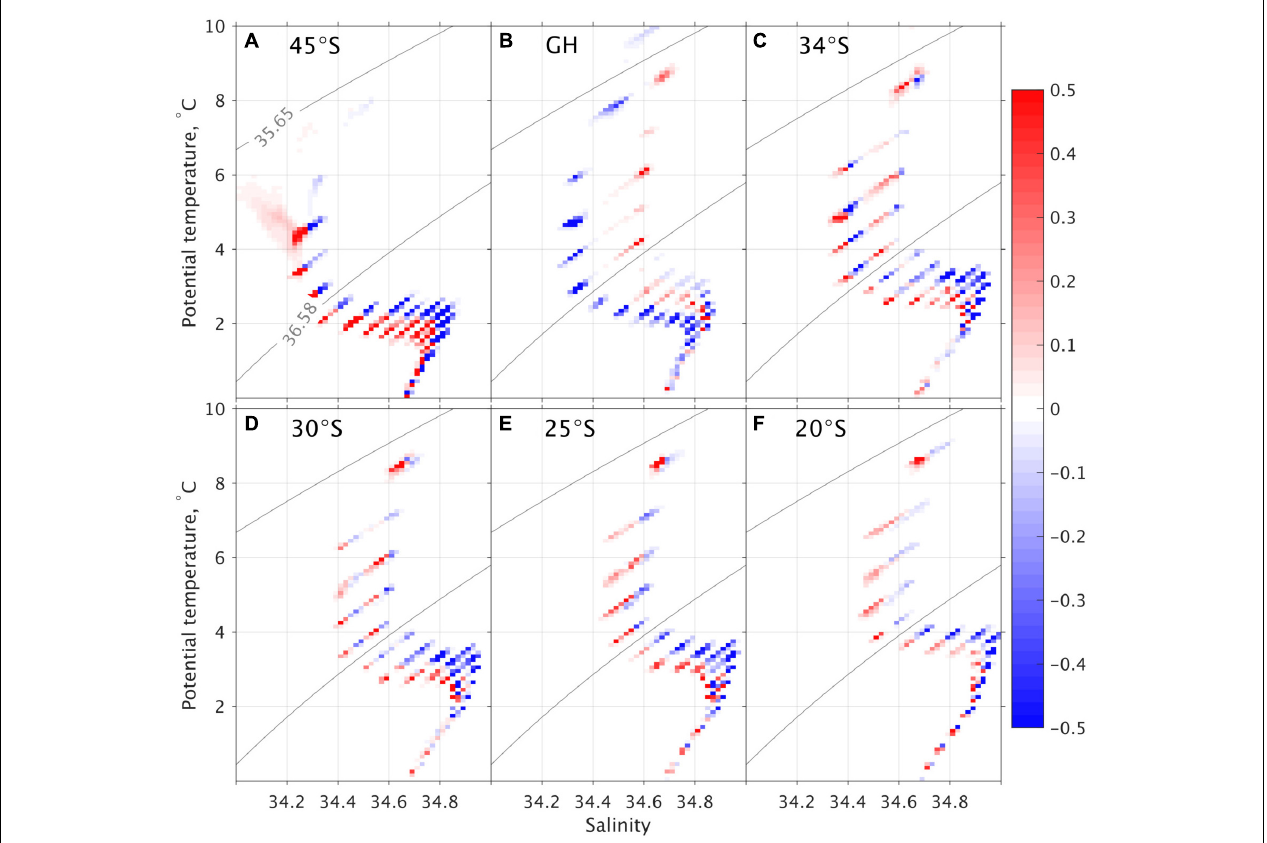
FIGURE 11 | Modeled meridional transports projected on potential temperature-salinity ( θ -S) plane across 6 sections ( A–F : 45 ◦ S, GH section, 34 ◦ S, 30 ◦ S, 25 ◦ S, and 20 ◦ S, respectively), presented in Sv over an area of (0.2 ◦ C × 0.04) in θ -S space. The red and blue colors represent north and south transports into and out of the South Atlantic. The isopycnal ( σ 2 ) surfaces of 35.65 and 36.58 kg m − 3 denote the upper and lower AAIW